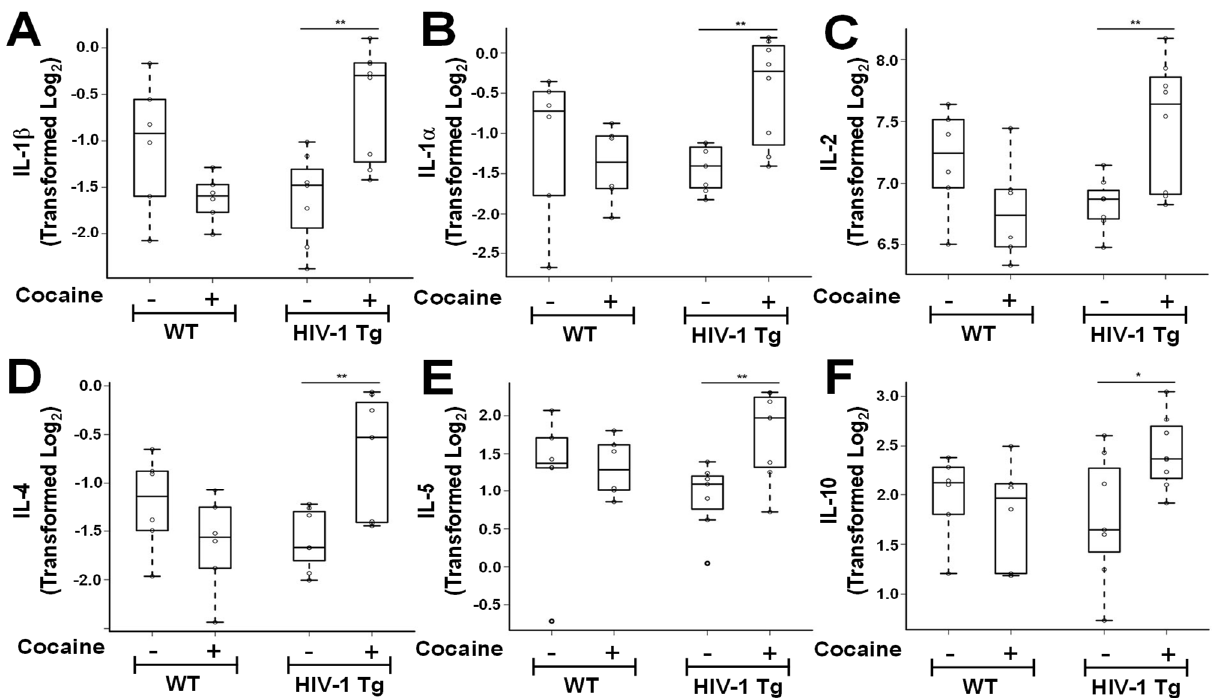
Figure 1. Cocaine self-administration regulates cortical interleukin levels in HIV-1 Tg rats. Equivalent total protein lysates from the frontal cortex (fCTX) were assayed for interleukin levels from WT saline-yoked ( n = 7), WT cocaine SA ( n = 8), HIV-1 Tg saline-yoked ( n = 6), and HIV-1 Tg cocaine SA ( n = 6) male rats. Protein levels for IL-1 β ( A ), IL-1 α ( B ), IL-2 ( C ), IL-4 ( D ), IL-5 ( E ), and IL-10 ( F ) are shown. Log 2 transformation was performed prior to statistical analyses since some expression levels were not normally distributed. * p < 0.05, ** p < 0.01.